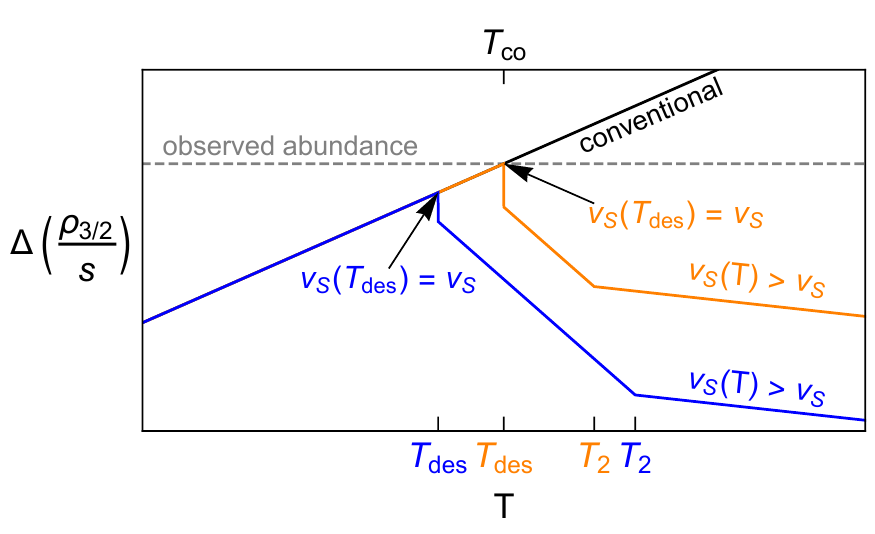
Figure 1 . This schematic diagram with log scale axes shows the suppression on gravitino production at high temperatures. The vertical axis is the gravitino abundance produced per Hubble time. The horizontal dashed line refers to the dark matter abundance observed today. The black and colored lines refer to the conventional and suppressed production